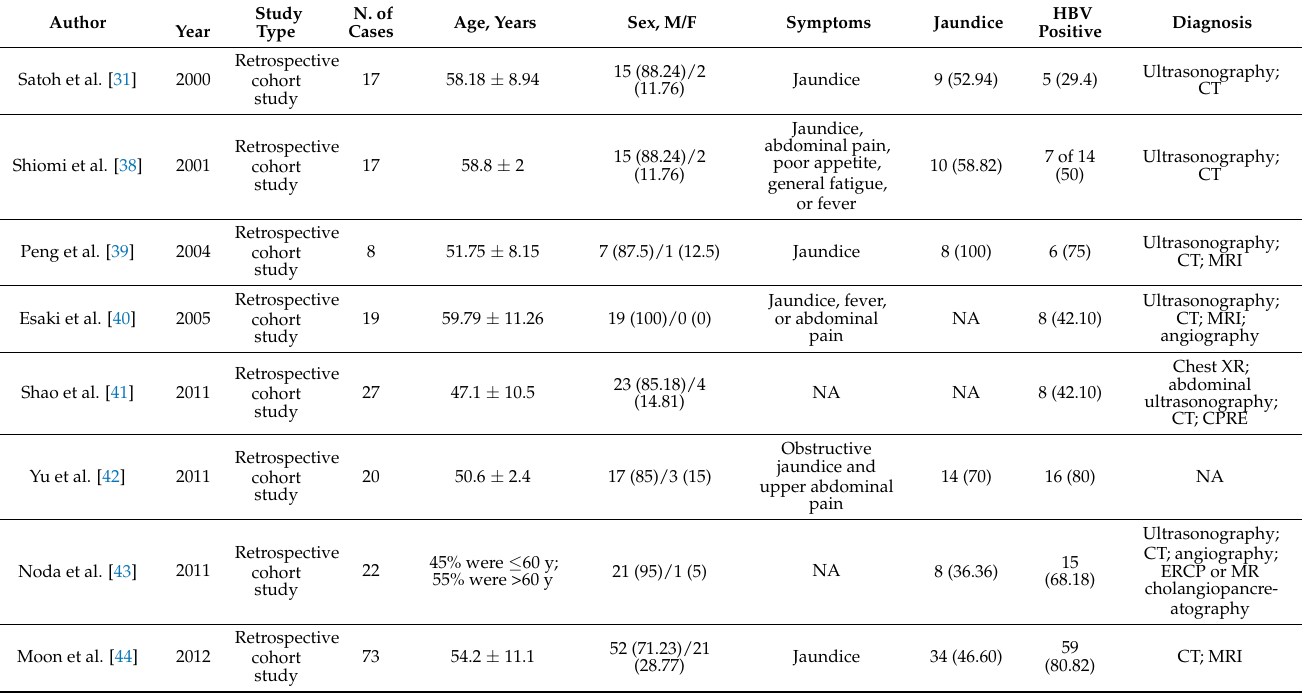
Table 1. Literature review: baseline